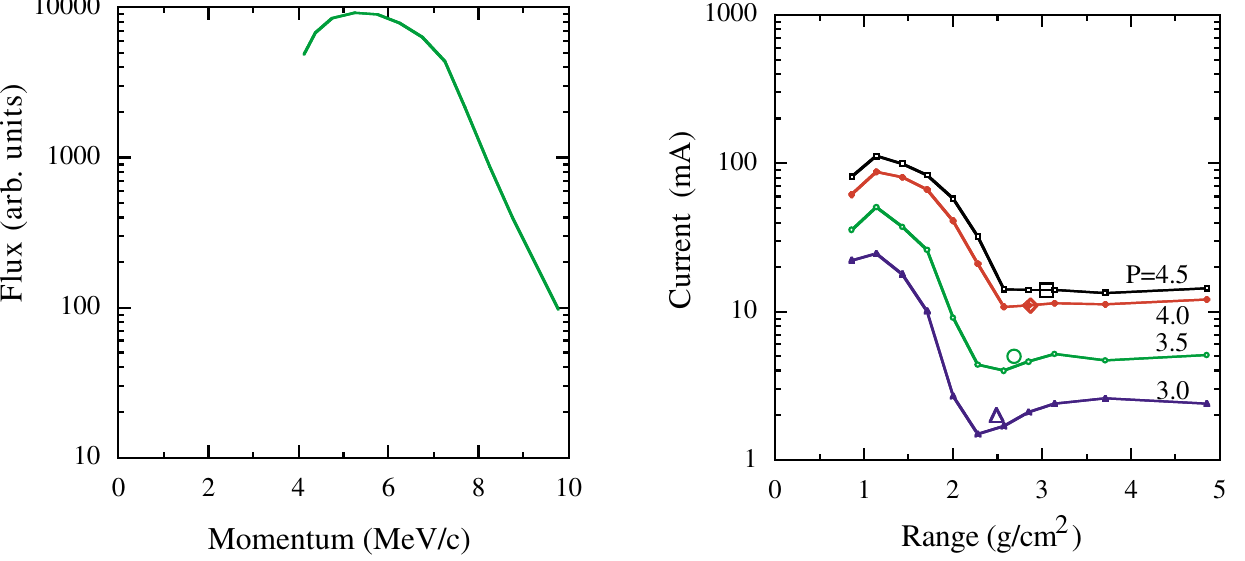
FIG. 9. (Color) Range measurements for different power levels (in MW). The range of the electrons is shown by the symbol.